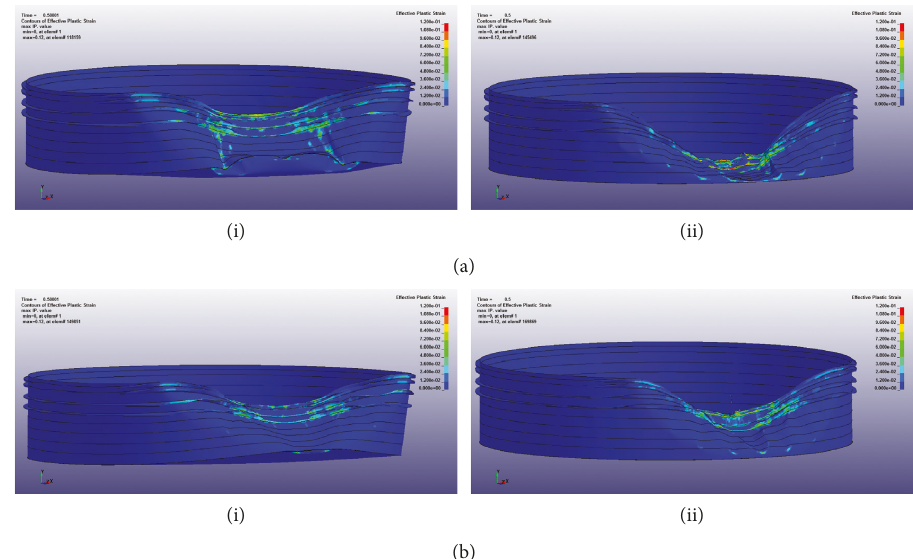
Figure 13: Structural deformation and failure state in different constraint conditions. (a) Storage tank with 25% fill level: (i) no constraint; (ii) fixed constraint. (b) Storage tank with 50% fill level: (i) no constraint; (ii) fixed constraint.